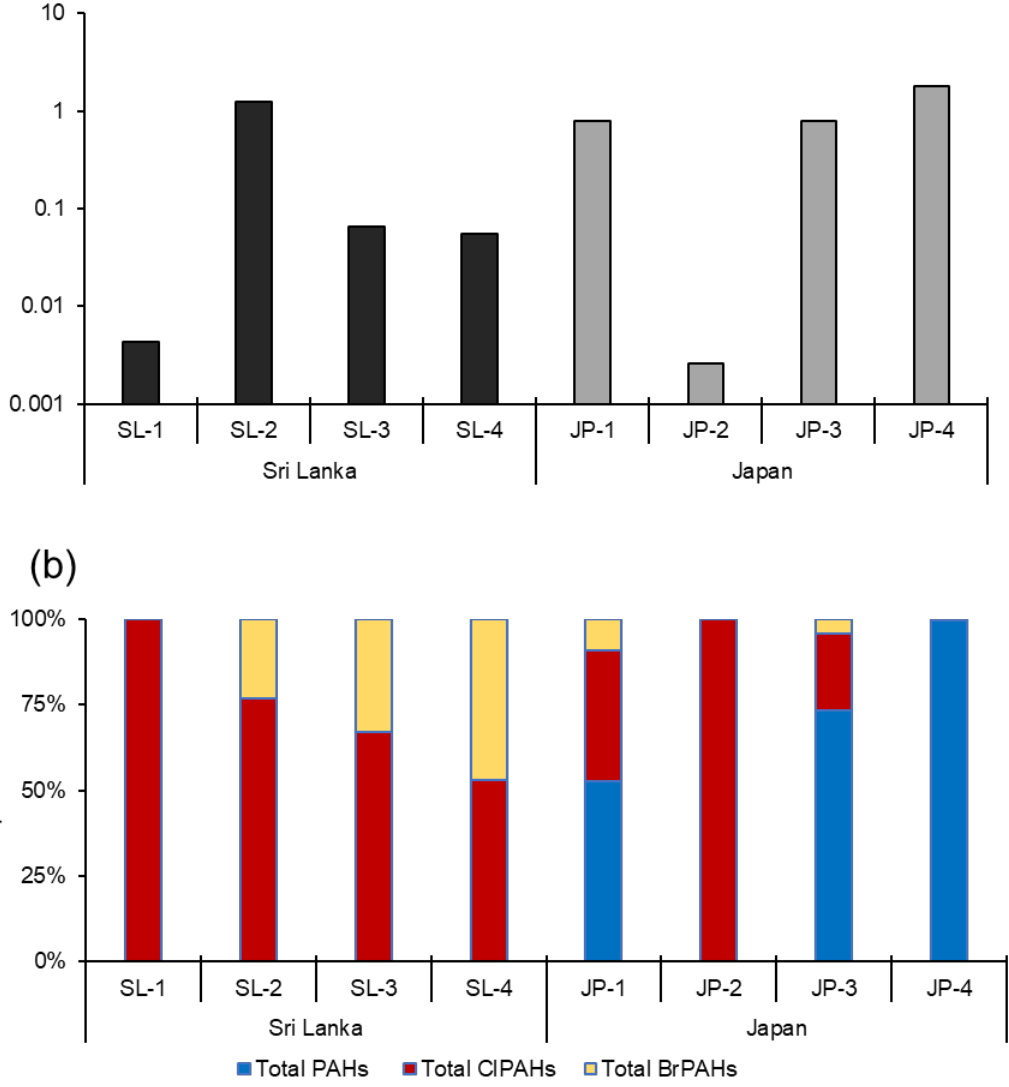
Figure 4. Dietary exposure-based toxic assessment calculated from toxic equivalent quotients (TEQ) for exposure to PAHs, ClPAHs, and BrPAHs. TEQ values were calculated for a teaspoon of milk powder in dry weight. ( a ) Total TEQ concentration and ( b ) composition of PAHs, ClPAHs, and BrPAHs.